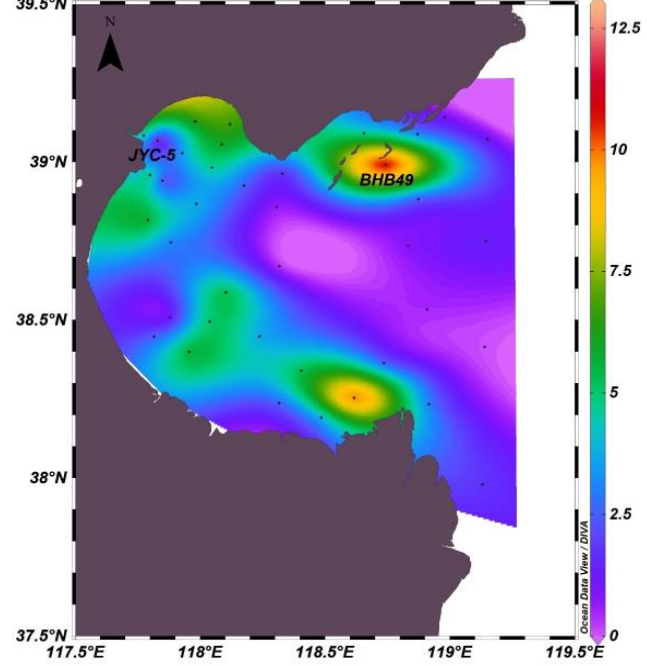
Figure 7. CO 2 air–sea flux (mmol/(m 2 · a)) distributions of surface seawater in Bohai Bay in summer 2020. The scale is 1:3,700,000. This image was created with ODV software, version 5.3.0 (Alfred Wegener Institute, Bremerhaven, Germany).